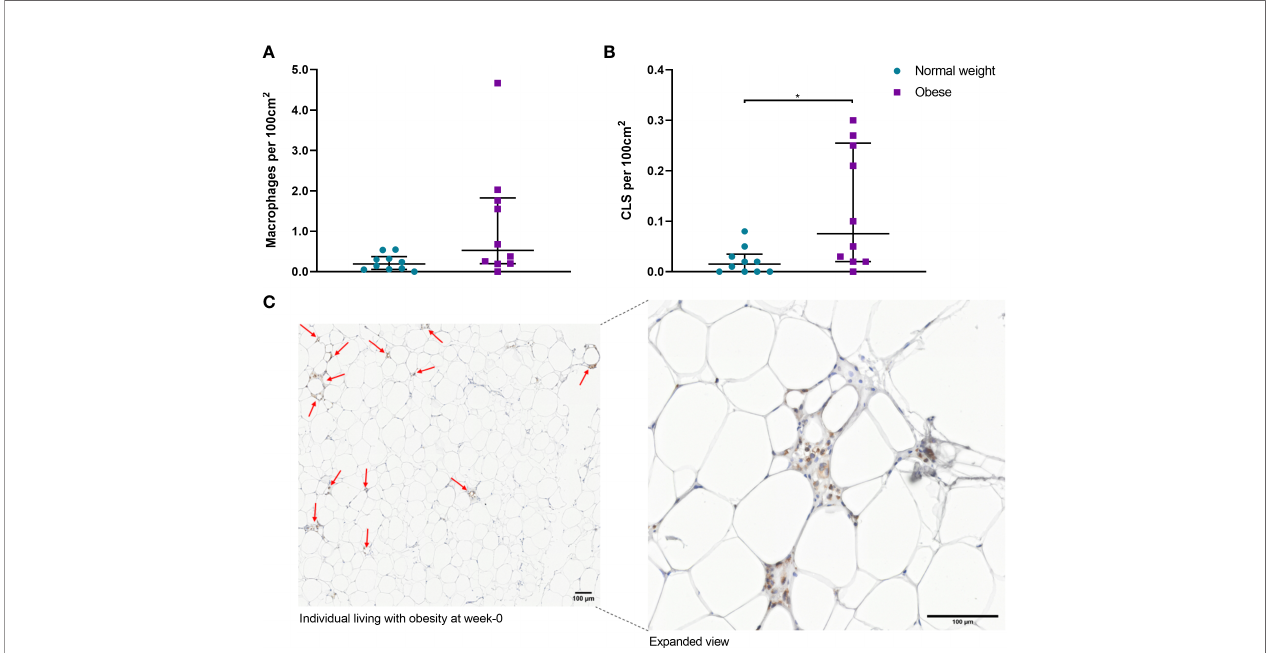
FIGURE 7 | (A) Number of macrophages per 100cm 2 of scWAT from normal weight and individuals living with obesity at week-0; (B) Number of CLS per 100 cm 2 of scWAT from normal weight and individuals living with obesity at week-0; (C) CD68 stained macrophages in a section of scWAT at 20 x magni fi cation from an individual living with obesity at week-0. * P = 0.023